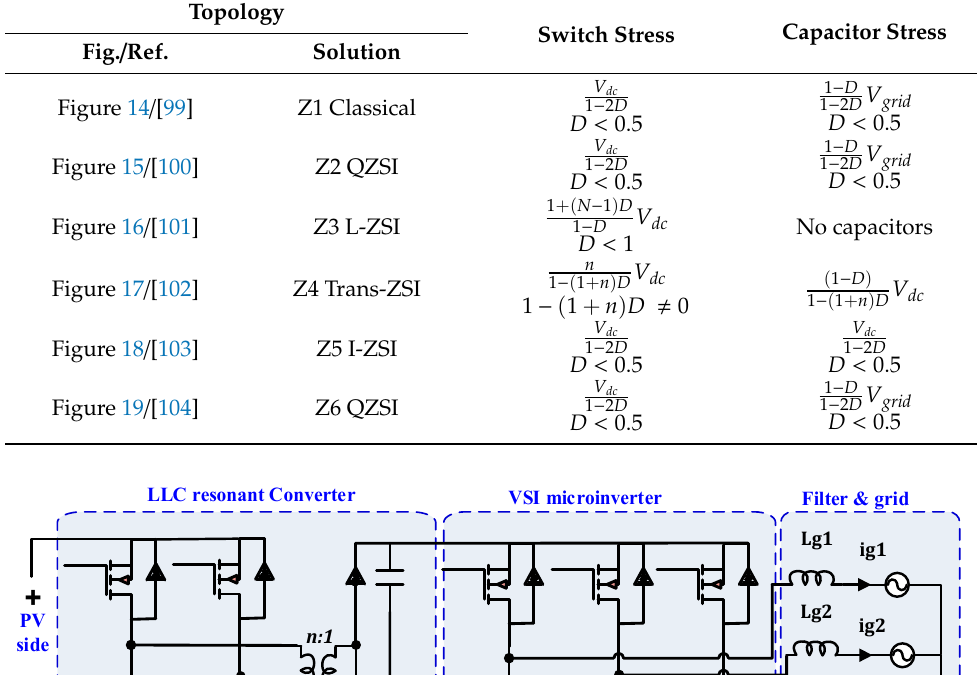
Table 4. Performance voltage stress for selected topologies of Z-source microinverters [99–104]. Topology Switch Stress Capacitor Stress Fig. / Ref.